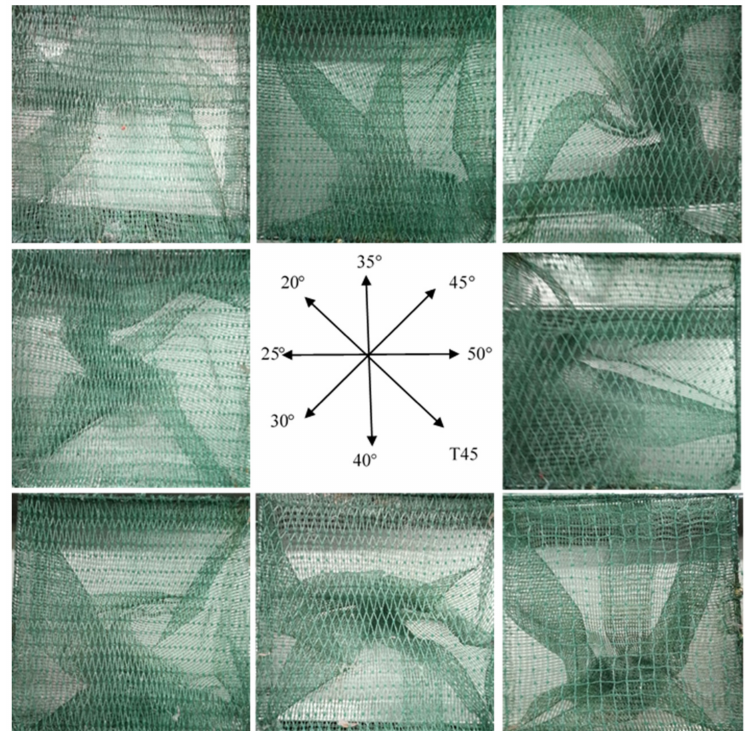
Figure 2. Experimental panels of 20 mm mesh size showing increasing opening angles from top to bottom and left to